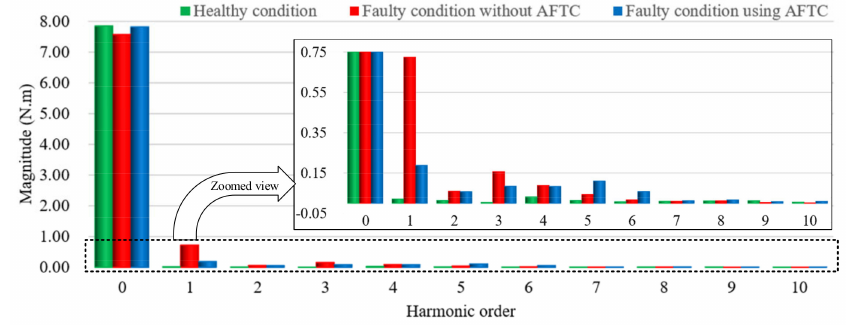
Figure 13. Comparison of spectrum of torque in healthy, OSF and fault-tolerant